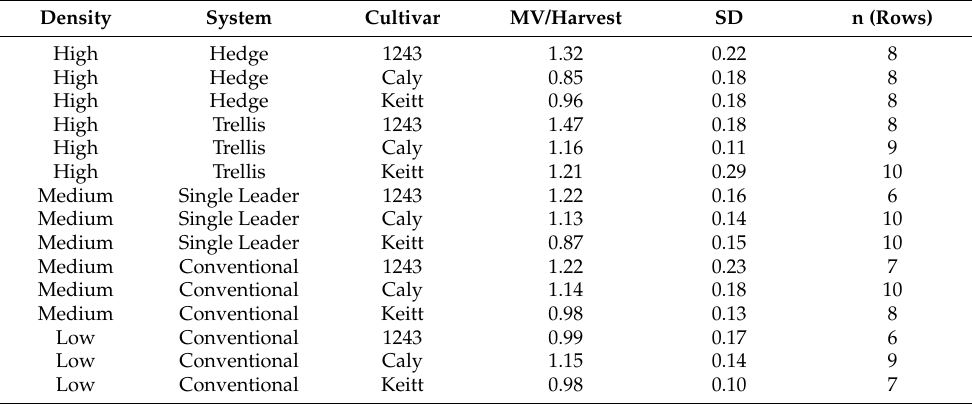
Table A1. 2019–2020 orchard characteristics. Cultivar abbreviations are Caly for Calypso ® , HG for Honey Gold and region abbreviations are NT for Northern Territory, NQLD for north Queensland, CQLD for central Queensland and SQLD for south Queensland. ‘-’ represents data not available. (Orchard numbering is tied to other